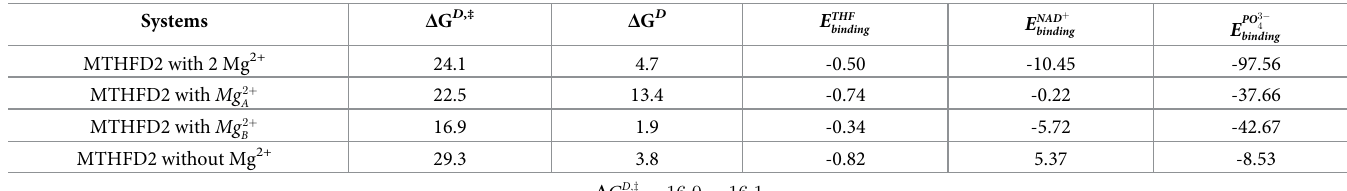
Table 1. Calculated binding energy and free energy (k cal /mol) for the dehydrogenase activity of MTHFD2. The D G D ; z k cat = 12.4 ± 0.71s -1 using transition-state theory.